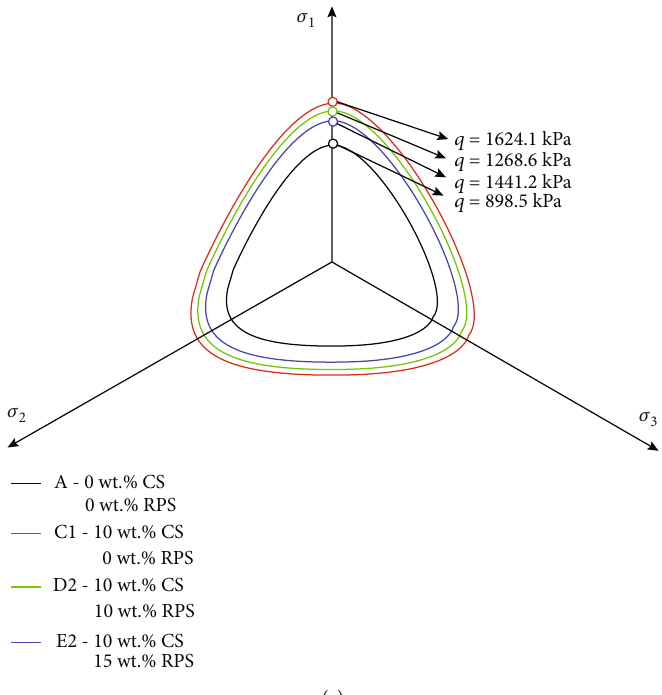
Figure 14: Yield curves of the 10wt.% carbide slag modi fi ed soils with di ff erent red Pisha sandstone contents under di ff erent con fi ning pressures: (a) σ 3 = 100 kPa ; (b) σ 3 = 200 kPa ; and (c) σ 3 = 400kPa